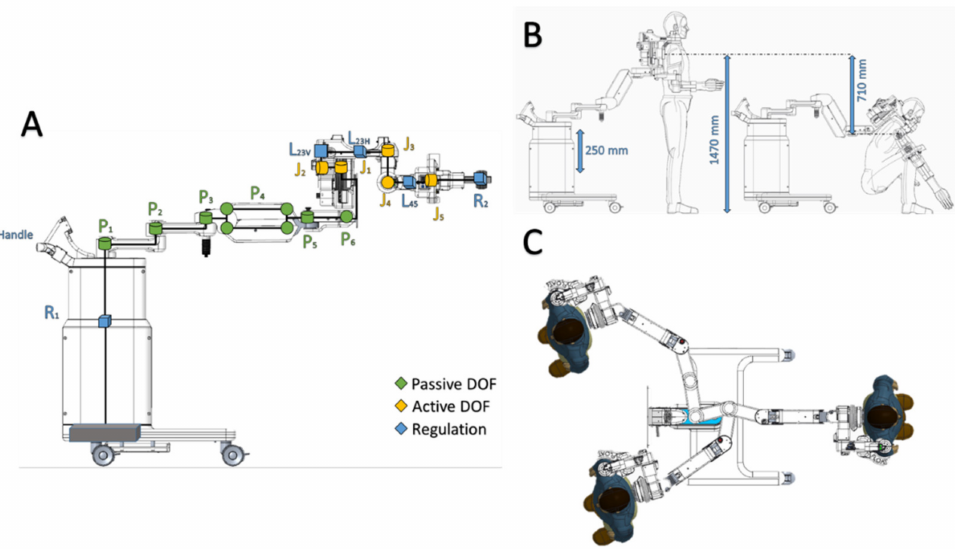
Figure 4. Float polyarticulated arm and operational limits. ( A ) Kinematic structure of the polyarticu- lated arm. ( B ) Vertical limits. ( C ) Top view, limits of the polyarticulated